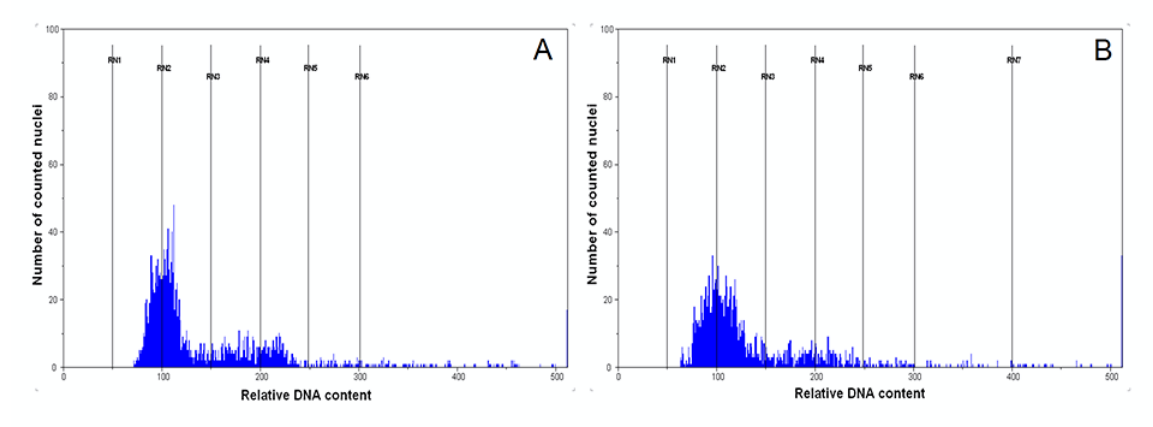
Figure 4 Histogram of relative DNA content in the nuclei of Primula farinosa leaf. Seed-origin ( A ) and micropropagated ( B ) plant.